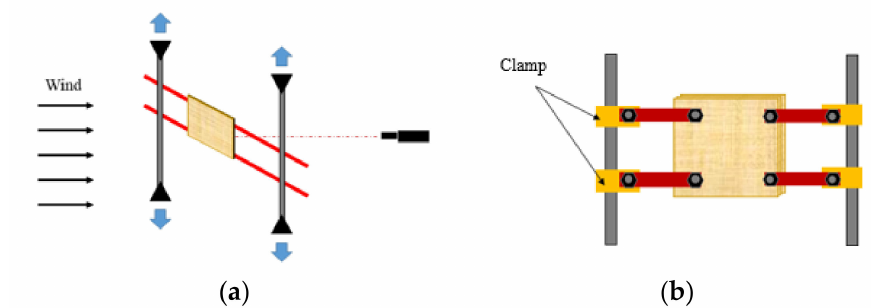
Figure 13. Specimen setup details: ( a ) vertical member; ( b ) horizontal member.